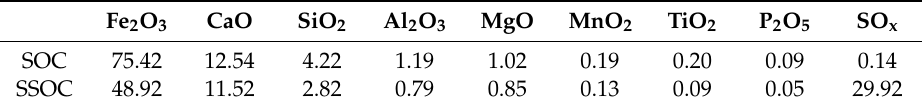
Table 1. Chemical compositions of catalysts